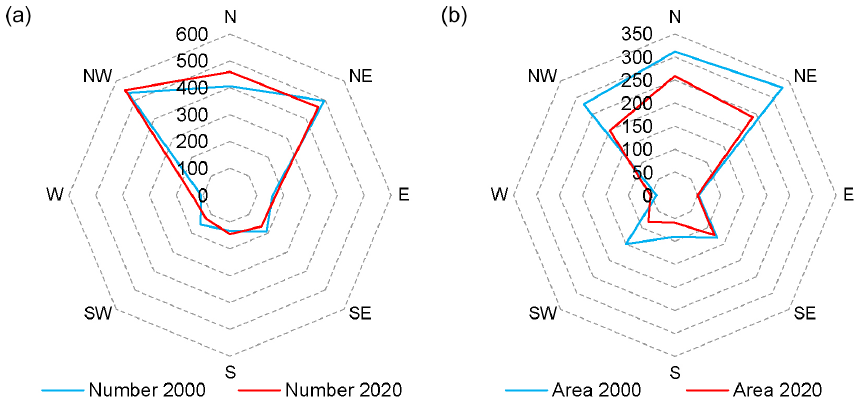
Figure 6. Proportion of glacier aspect by (a) count and (b) area (km 2 ) in 2000–2020.